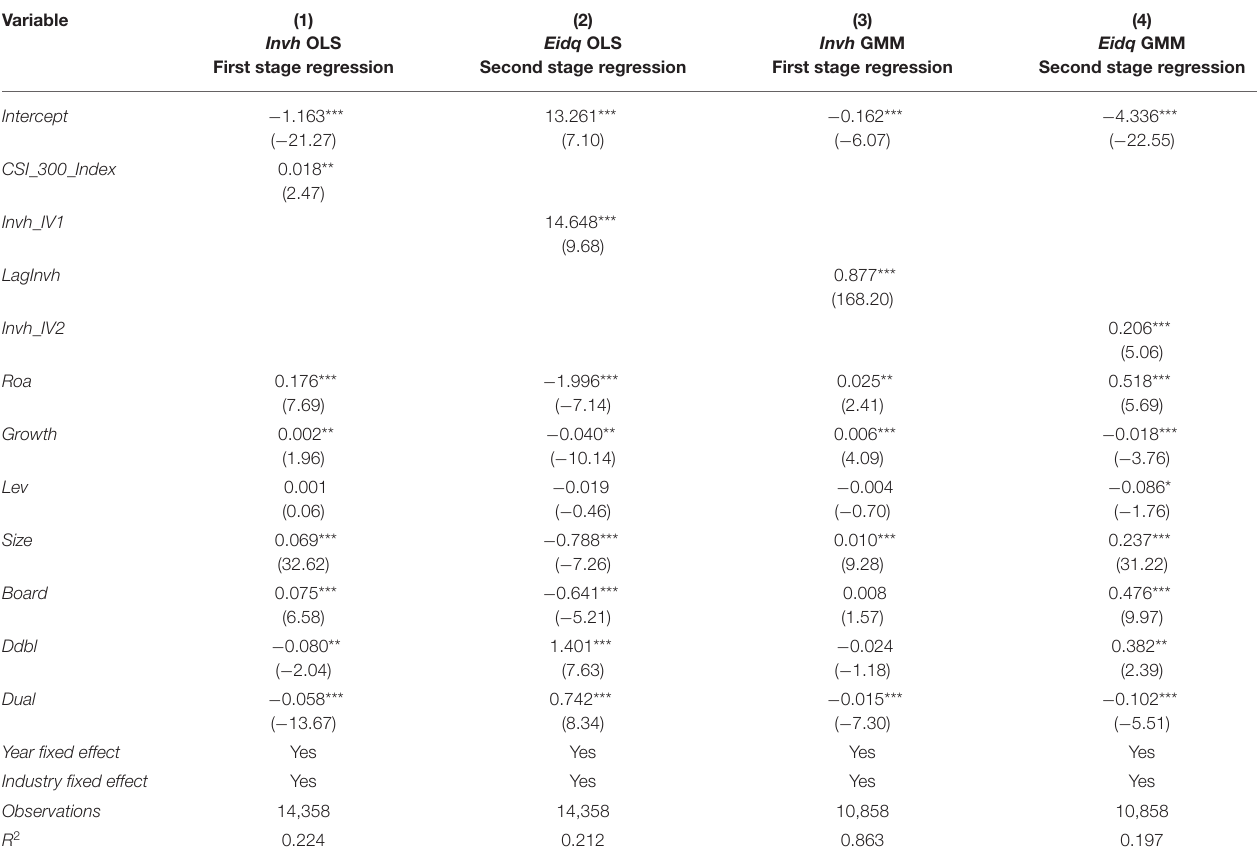
TABLE 6 | Institutional investors’ heterogeneity and environmental information disclosure quality: endogenous test.